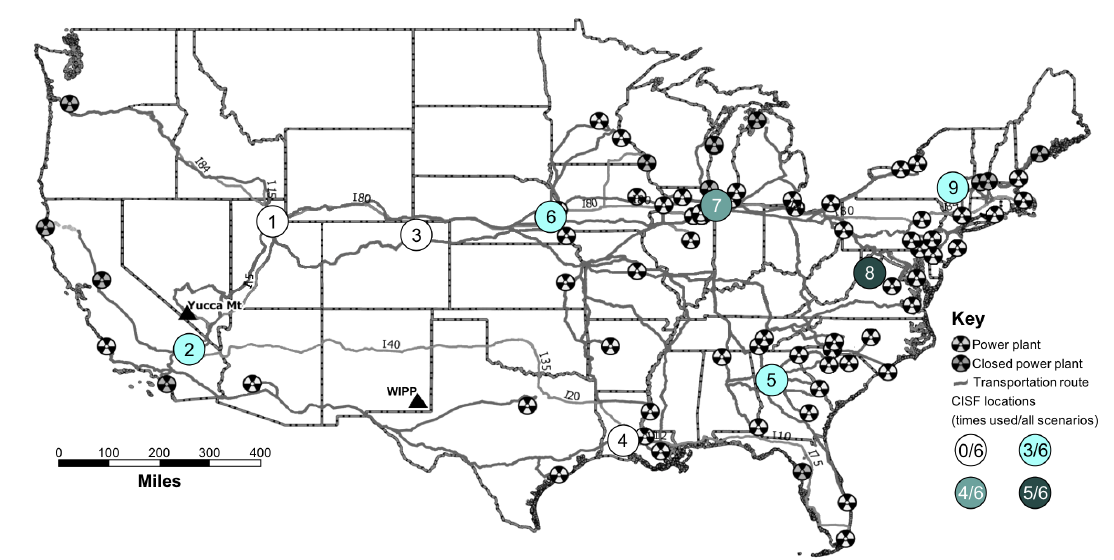
Figure 6. Realized consolidated interim storage facility (CISF) locations in all scenarios. Source: own representation based on